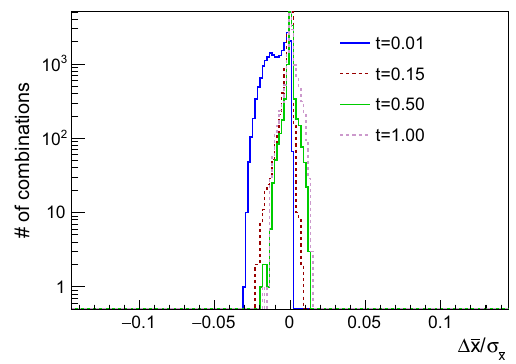
0.9 σ r Δ Fig. 6 Ratio of the uncertainties on the combined value obtained using the method proposed here and the direct likelihood combination. The distribution is shown for different values of the correlation c between the systematic uncertainties of both